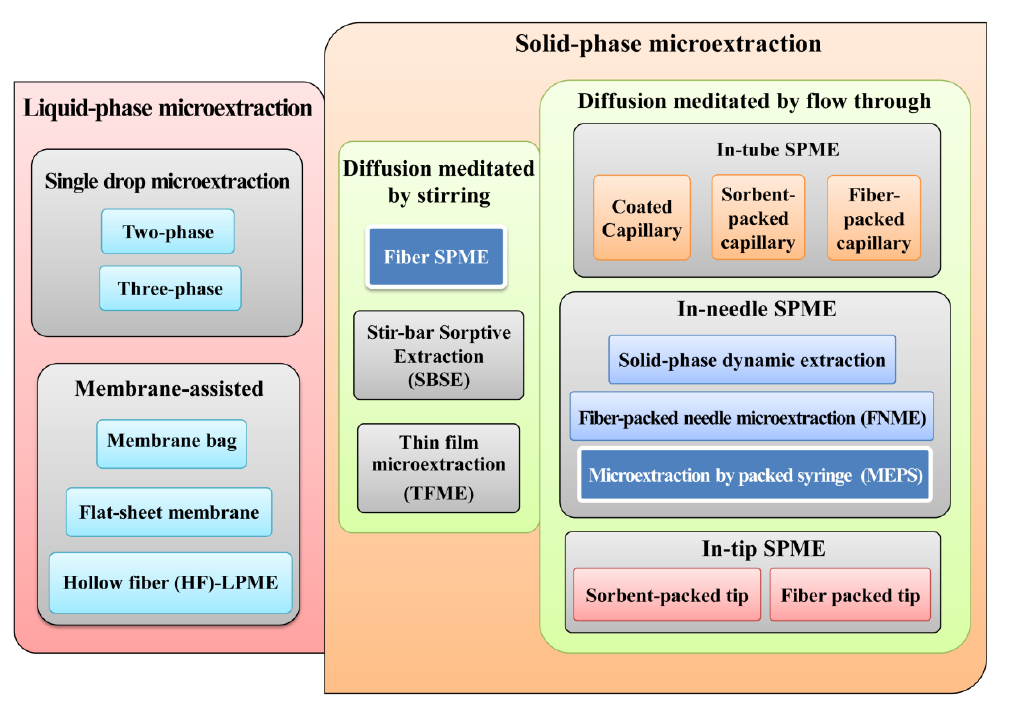
Figure 1. Classification of microextraction techniques